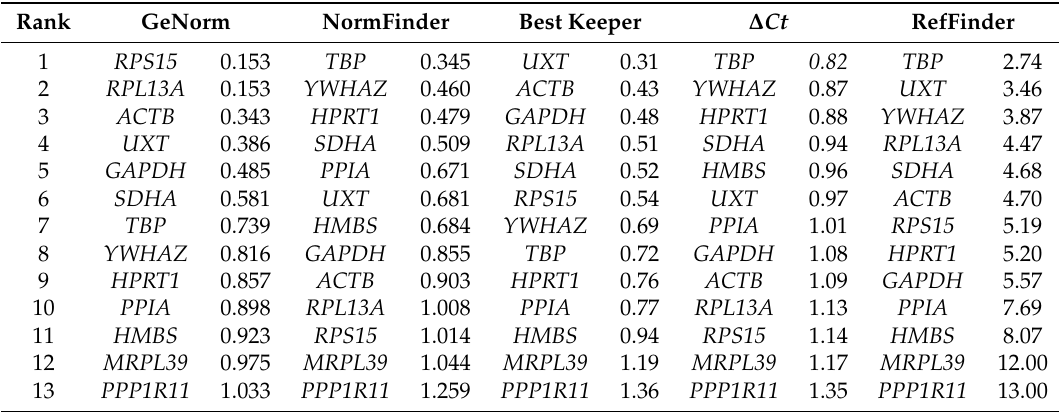
Table 2. Stability of RGs all developmental stages of yak testis.